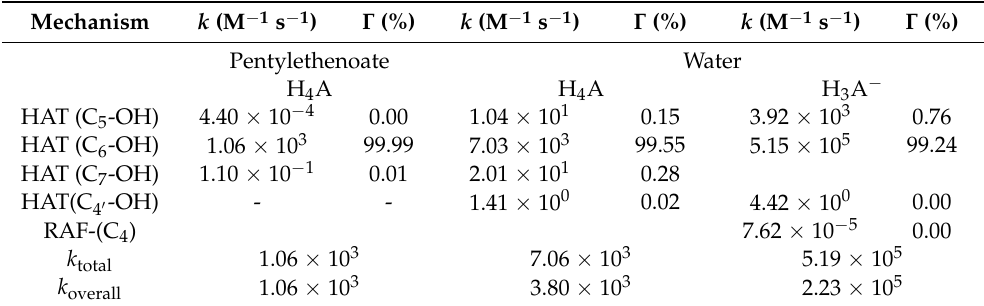
Table 4. Rate constants ( k ) and branching ratios ( Γ ) of reaction between scutellarein and OOH radical calculated at 298.15 K. k total was calculated as the sum of the individual rate constants from the considered reaction paths, while k overall is the sum of the rate constants for the different species present in solution at pH = 7.4.